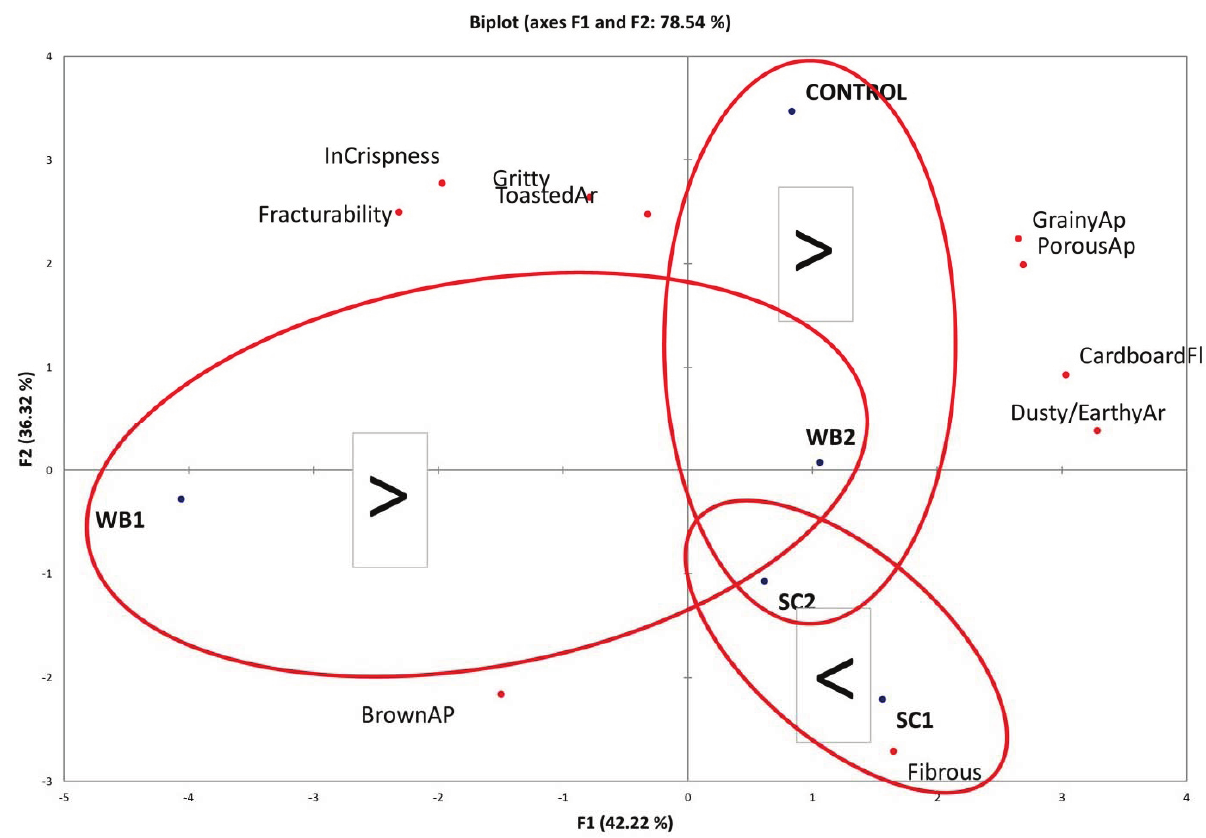
Figure 3. Principal Components Analysis of treatments for the significantly different appearance (Ap) texture, aroma (Ar), and flavor (Fl) attributes. Texture attributes were included based on the uncoated treatment descriptive sensory analysis results. In Crispness—Initial crispness. The < and > symbols indicate the direction of the palatability test for the comparisons of samples within the